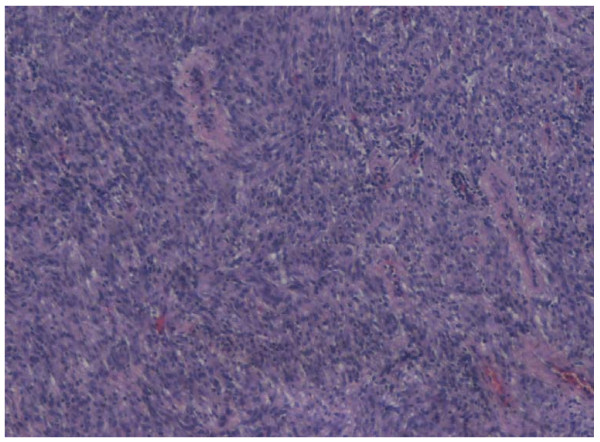
Gastric GIST in H-E stain (×20)